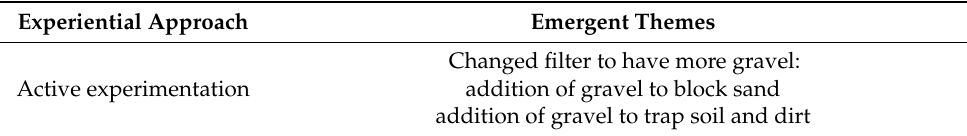
Table 3. Qualitative Text Analysis of Water Concepts and